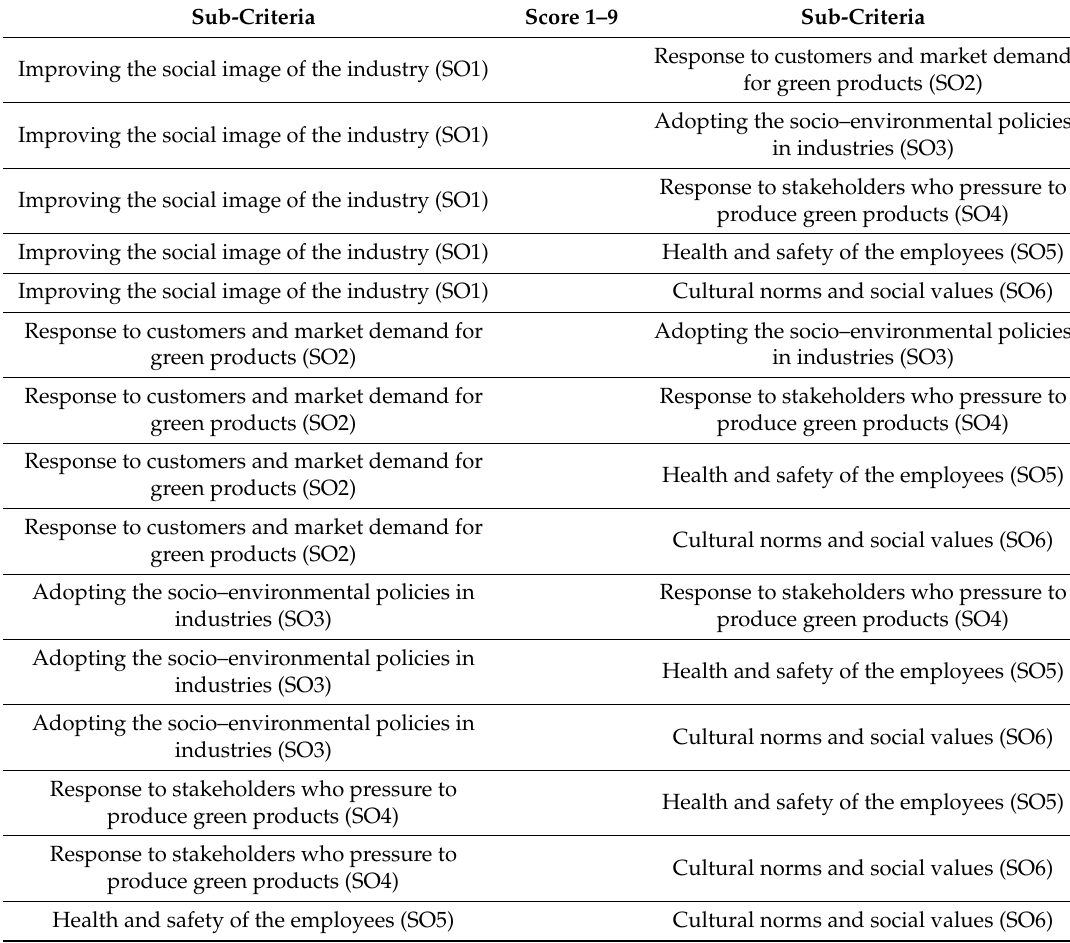
Table A3. Please rate the importance of sub-criteria (SO1–SO6) against each sub-criteria (SO1–SO6) relating to social (SO)